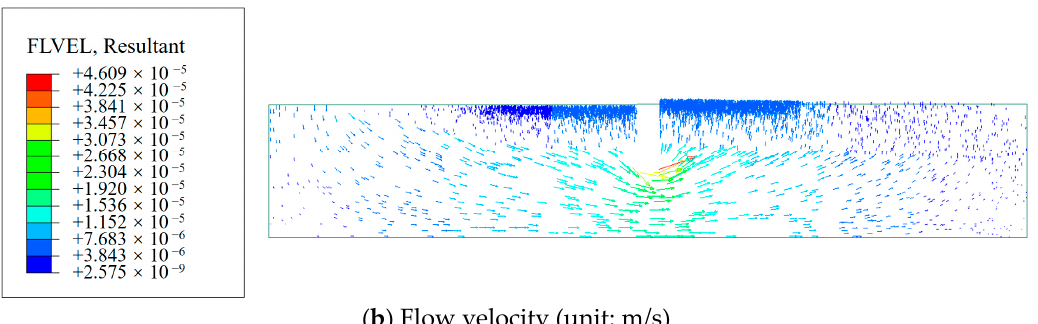
Figure 10. Pore water pressure and flow velocity of the bedrock with a reservoir water level of 600 m.